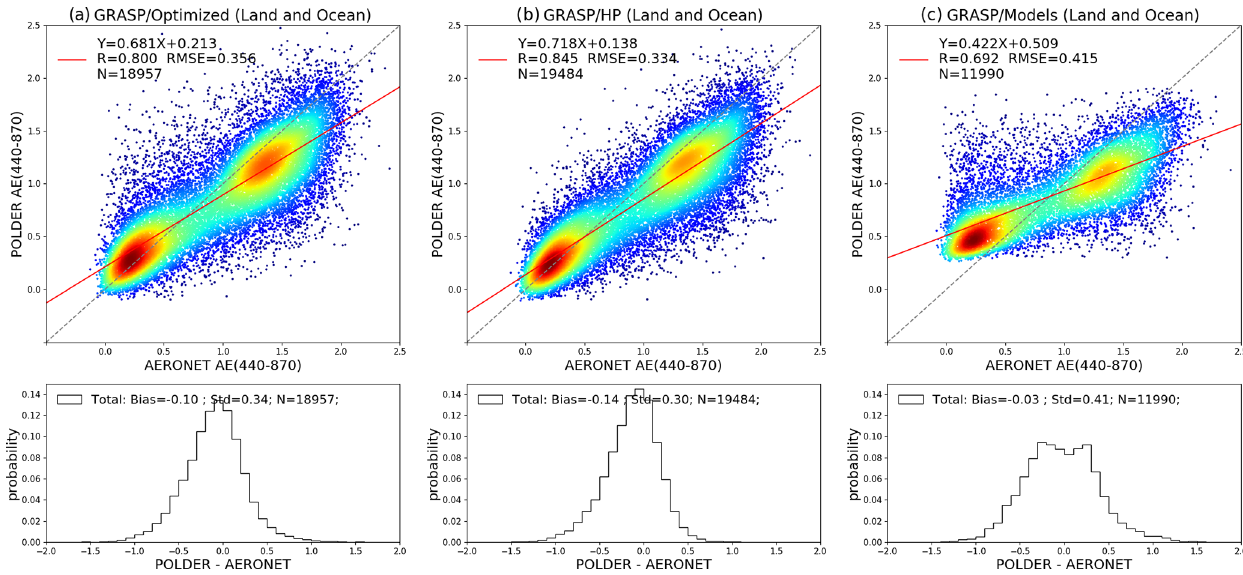
Figure 3. Evaluation of all archive PARASOL/GRASP AEs (440 / 870) against AERONET: (a) GRASP/Optimized, (b) GRASP/HP, (c) GRASP/Models. The gray dashed line and the red solid line are the 1 : 1 reference line and the linear regression line. The probabil- ity density functions of differences (POLDER–AERONET) are present in the lower panels. Table 5. Global statistics of PARASOL/GRASP AODF vs. AERONET SDA AODF at 550nm over land and ocean. The best performing of three approaches by each metric is labeled in